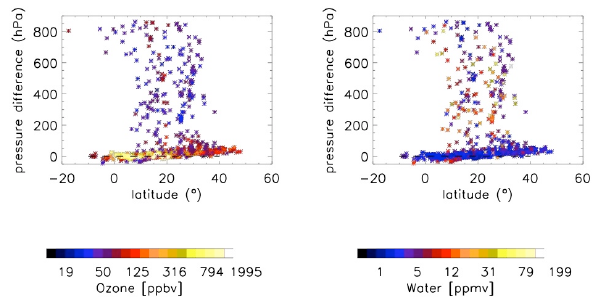
Fig. 6. Scatter plot of the pressure differential versus latitude dif- ferential along the back trajectories starting from M55 flight tracks, colour coded in terms of ozone in ppbv (left panel) and water vapour inppmv (right panel) observed along the flights.